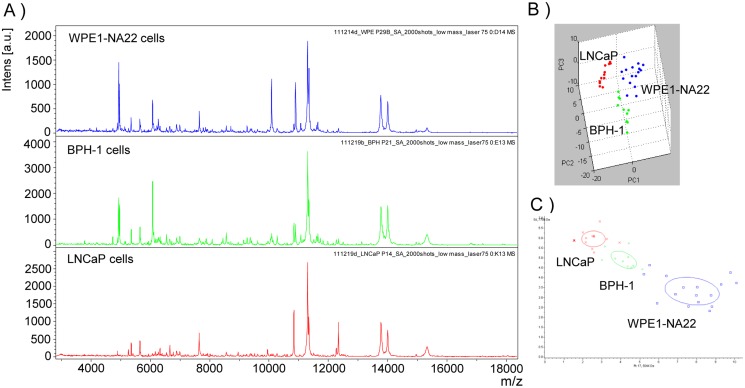
Protein spectra of human prostate cells.(A) MALDI MS protein mass spectra, (B) principal component analysis (PCA) score plot, and (C) comparison of the two most discriminant peaks across samples.